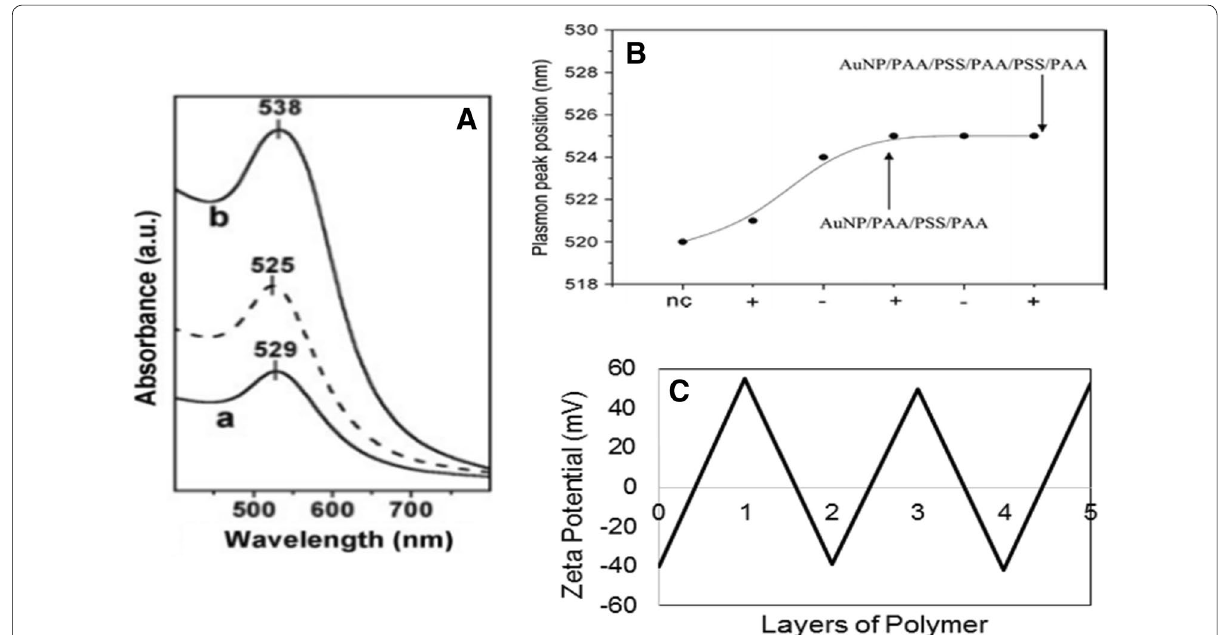
Fig. 3 A UV–Vis spectra of mercaptoundecanoic acid coated AuNPs (dashed line) subsequently coated in (a) Polydiallyldimethylammonium chloride (PDADMAC) and (b) PDADMAC/polystyrenesulfonate (PSS). Reproduced from Ref. [61] with permission from Wiley. B Surface plasmon band shifts compared to the number of polyelectrolyte coatings on the AuNPs. Reproduced from Ref. [52] with permission from Wiley. C Zeta potential of uncoated citrate capped AuNPs (0) then subsequent addition of positively charged polyallylamine (PAA) and negatively charged polystyrenesulfonate (PSS). Reproduced and adapted from Ref. [52] with permission from